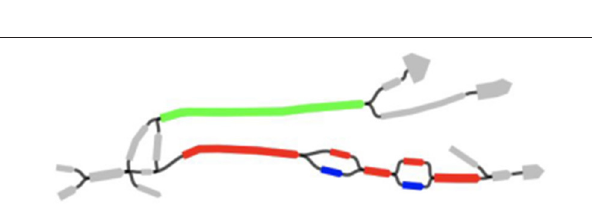
FIGURE 3 | bla CTX − M paths and their neighborhood. Green path corresponds to CTX-M-15 variant; blue and red corresponds to CTX-M-9 and CTX-M-14,